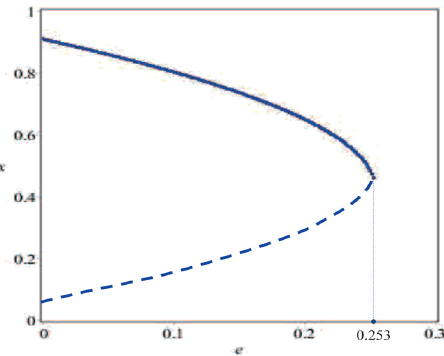
Figure 1: Fold bifurcation diagram of system ( 1.3 ) in the ( ) e x , plane where parameters are given in ( 4.1 ) and the initial value is ( ) 0.5, 0.2 . The dash curve corresponds to the unstable fi xed point E 1 ∗ , and the solid curve corresponds to the stable fi xed point E 2 ∗ . The fold bifurcation value is e 0.253 ≈ ∗